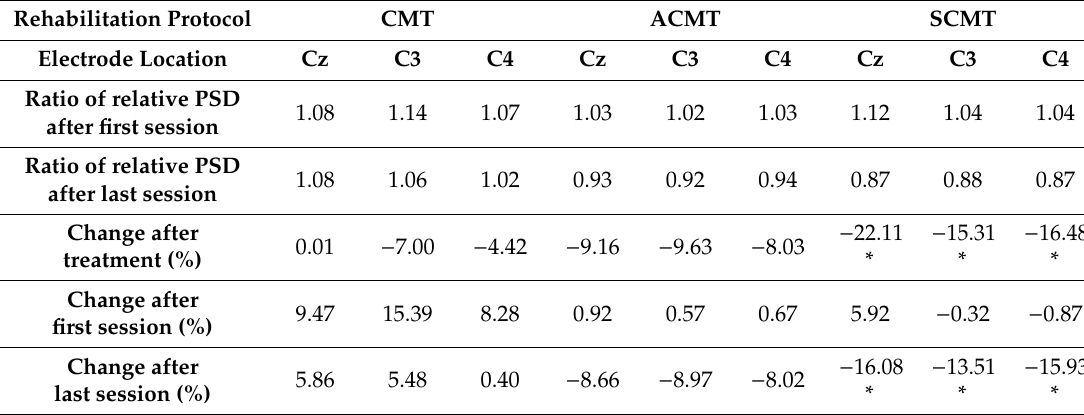
Figure 6. Ratio of relative power spectral density (PSD) for each type of treatment: ( a ) conventional mirror therapy (CMT), ( b ) asynchronous mode continuous passive motion (CPM) − MT (ACMT), and ( c ) synchronous mode CPM − MT (SCMT); ( A ) after first session and ( B ) after last session (* p < 0.05). Table 1. Ratio of relative power spectral density (PSD) analysis after each rehabilitation